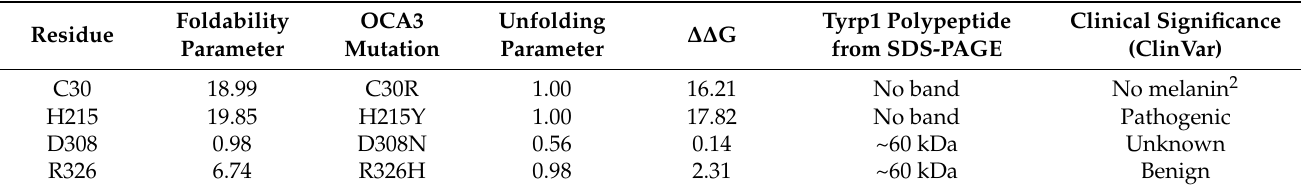
Table 1. Foldability, unfolding parameters, and ∆∆ G values generated by UMS for each residue and mutation of interest.